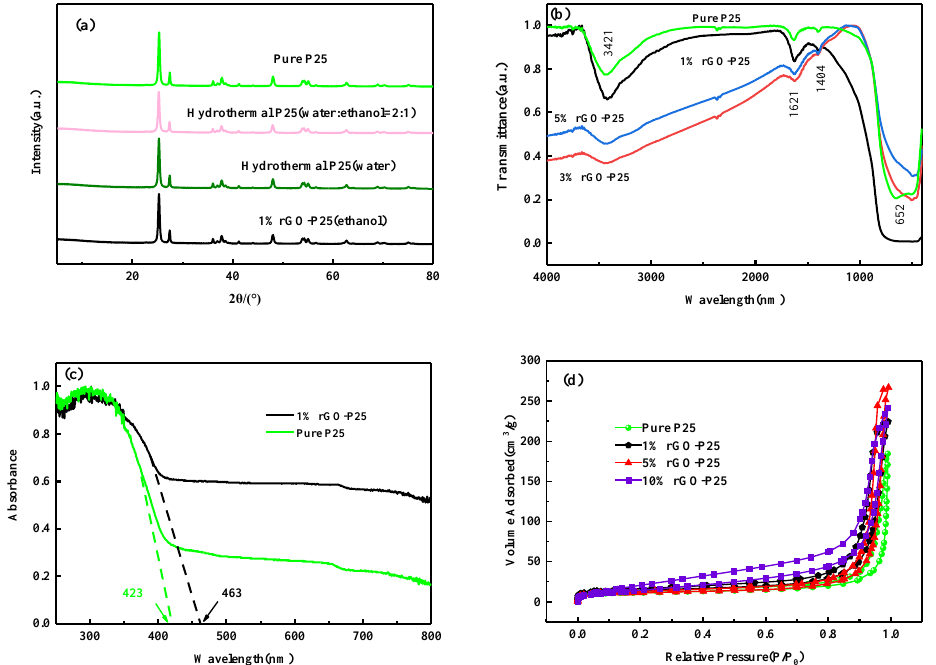
Figure 2. ( a ) XRD patterns of 4 photocatalysts; ( b ) FTIR spectra of pure P25, 1%, 3%, and 5% rGO–P25; ( c ) UV–vis di ff use reflectance spectra of pure P25 and 1% rGO–P25; ( d ) Nitrogen adsorption-desorption